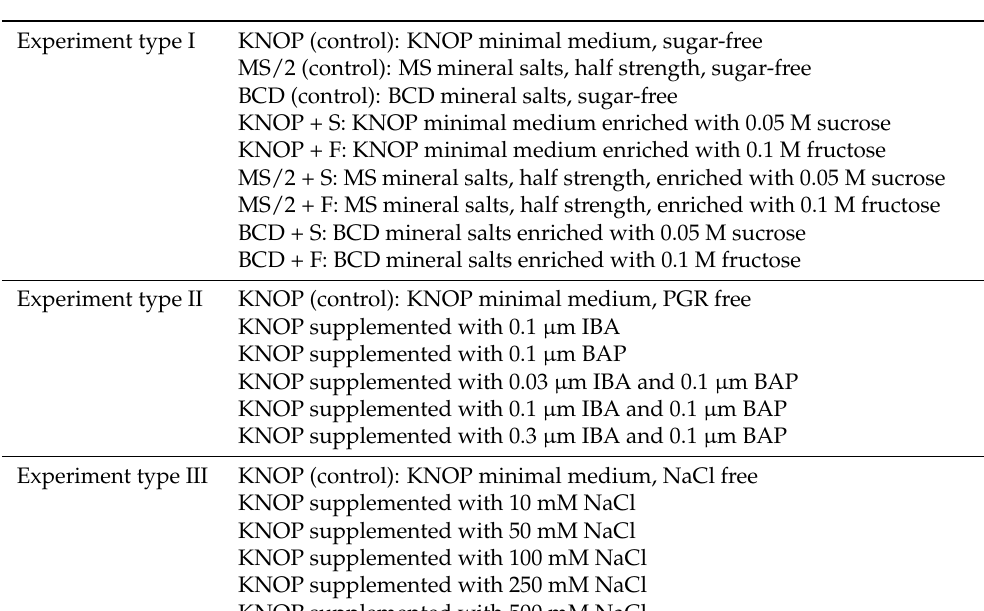
Table 1. Experimental design summary. Each treatment included 20 replicates. The growth conditions were as described in Section